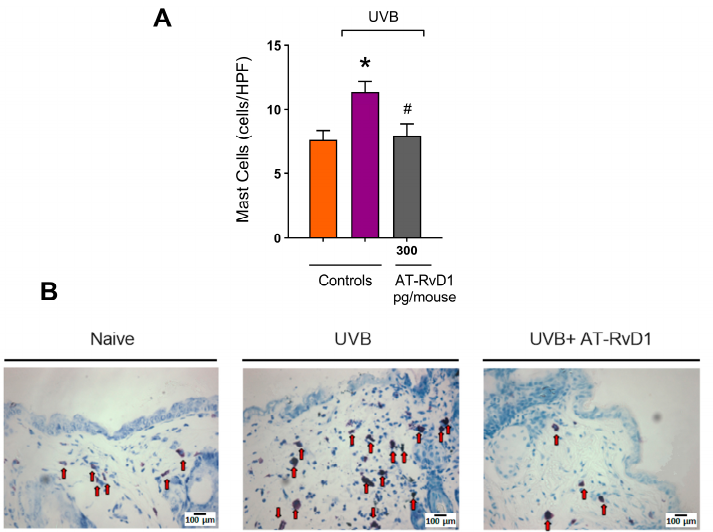
Figure 4. Effect of 300 pg/mouse AT-RvD1 on dermal mast cell infiltration in hairless mouse skin exposed to 4.14 J/cm 2 UVB radiation. The number of mast cells ( A ) and representative images of mast cells in the toluidine-blue-stained dermis ( B ). Skin samples were collected 12 h after the exposure. Arrows indicate mast cells. Bars represent means ± SEM. Two separate experiments with five groups of 5 mice per group per experiment were performed. Statistical analysis was performed by one-way ANOVA, followed by Tukey´s post hoc test. * p < 0.05 compared to the nonradiated control group (orange bar); # p < 0.05 compared to the radiated control group (purple bar).